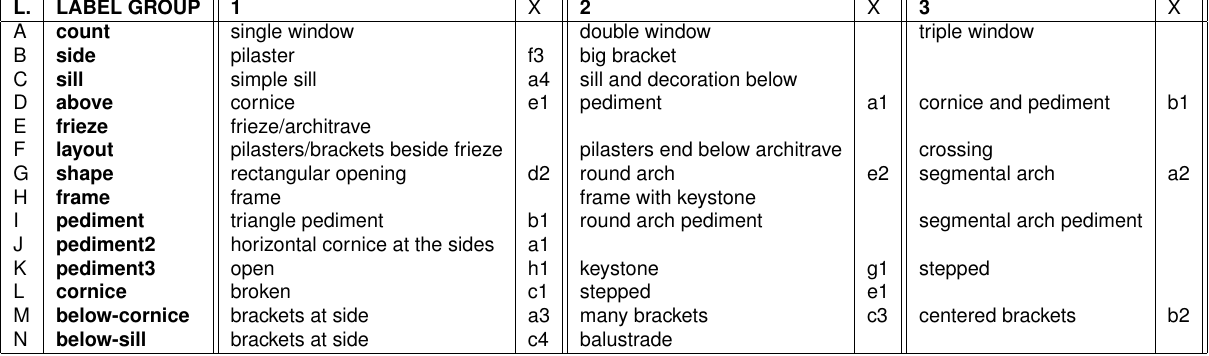
Table 1: This labeling table is the result of the analysis phase (Section 3). Every label, e.g. A1, is associated with a set of observations